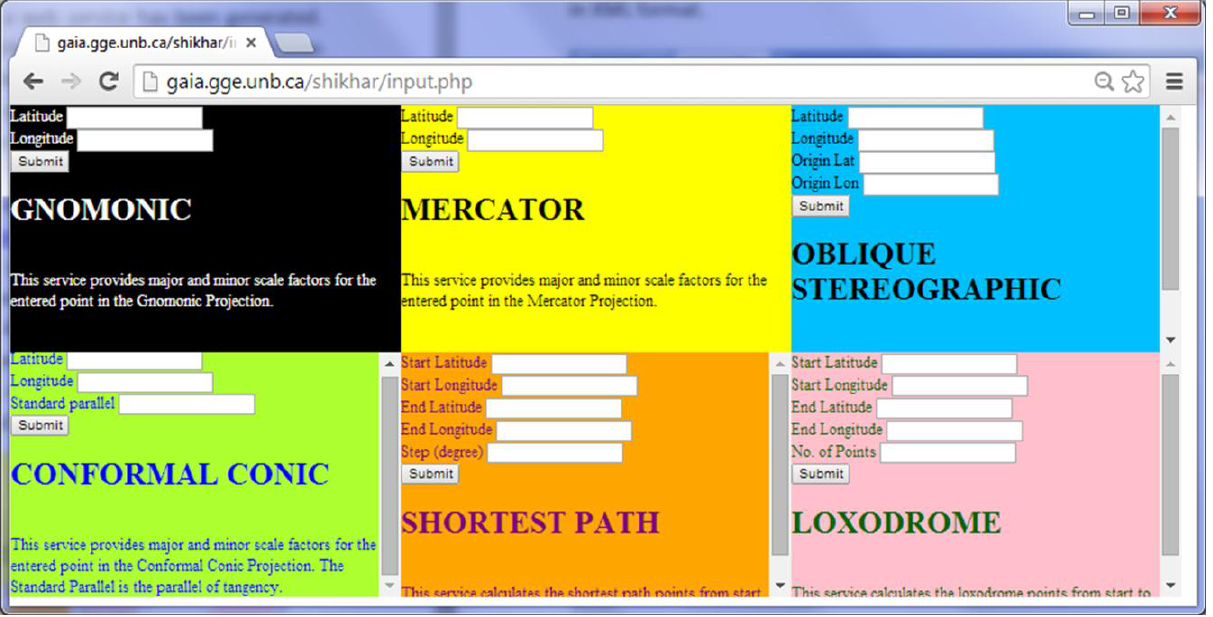
Figure 9. Interface to the web services (currently available at: